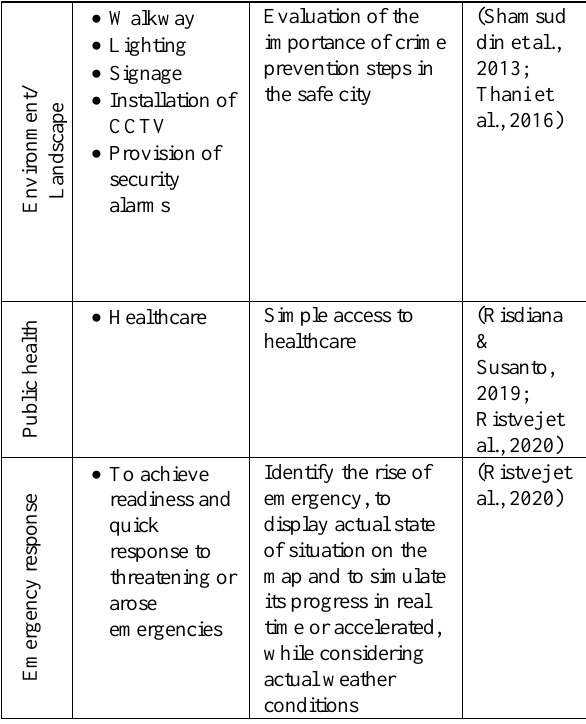
Table 3. List of indicators, sub-indicators, and it’s descriptions. Based on the models, indicators, and frameworks from the